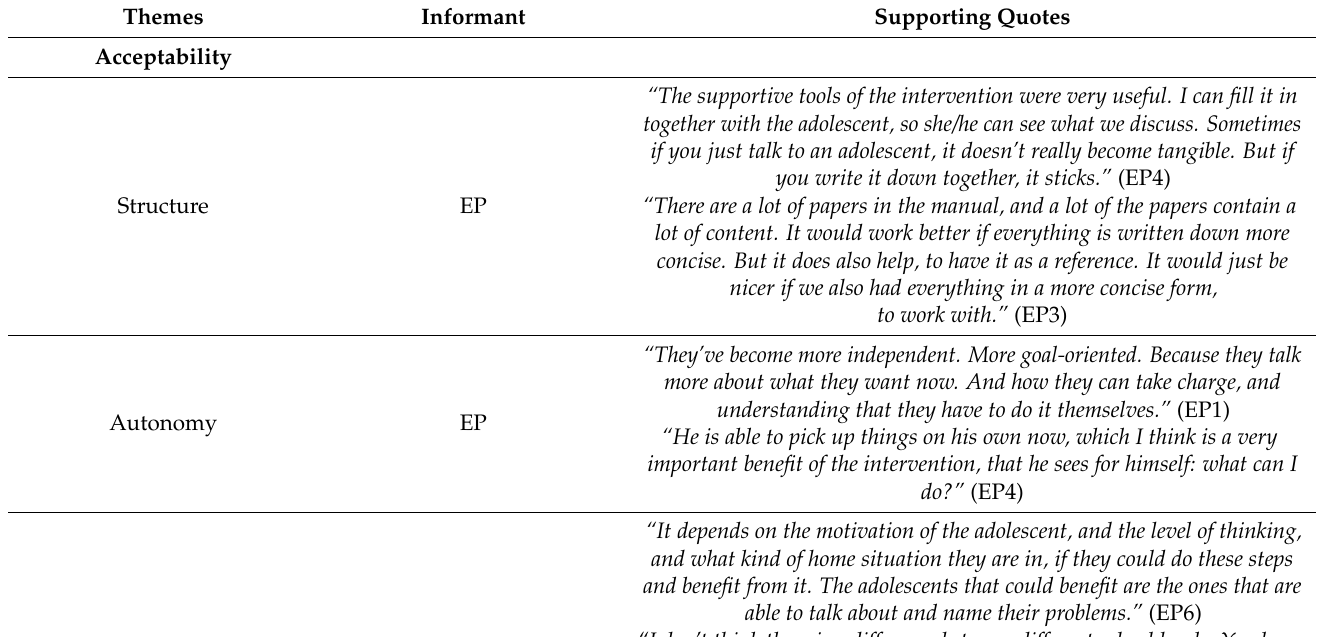
Table 4. Supporting quotes regarding the acceptability of the